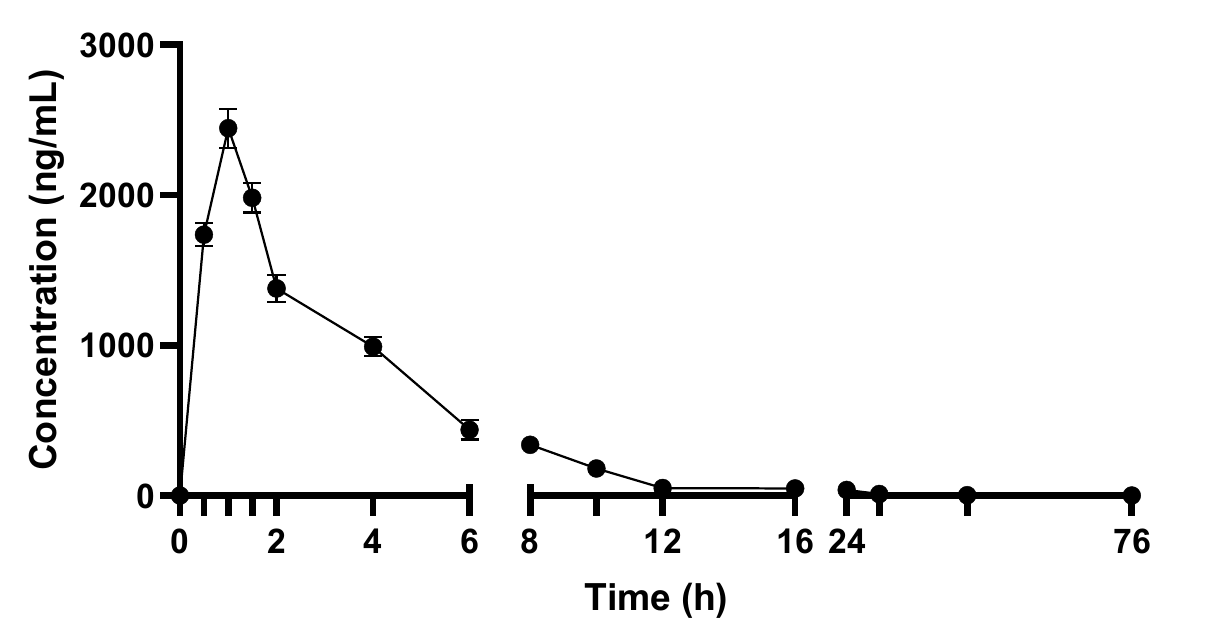
Figure 1. Plasma concentration–time profile of TEF in terms of GA-H after its oral administration to rats.